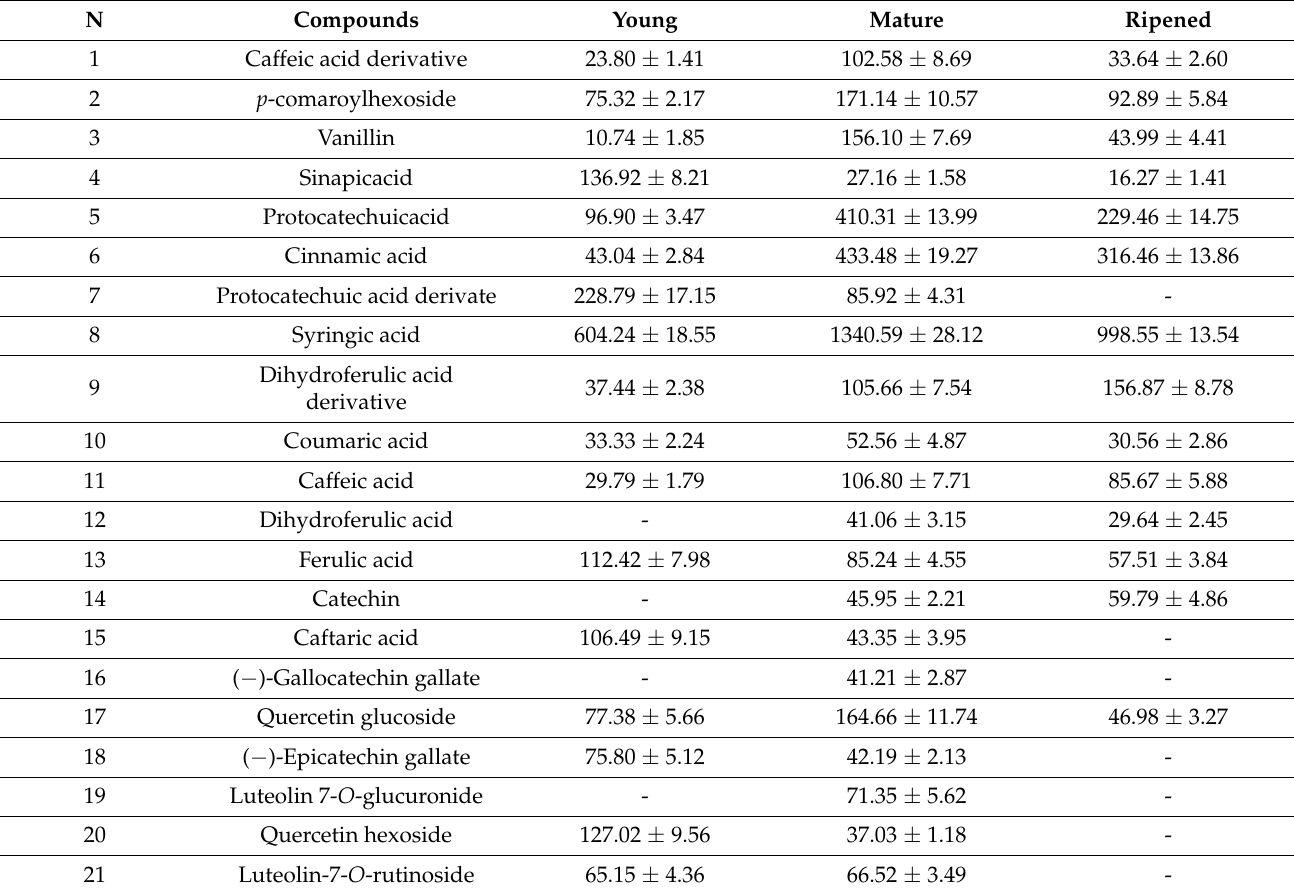
Table 3. Quantification of C. moschata polyphenols in young, mature and ripened fruits ( µ